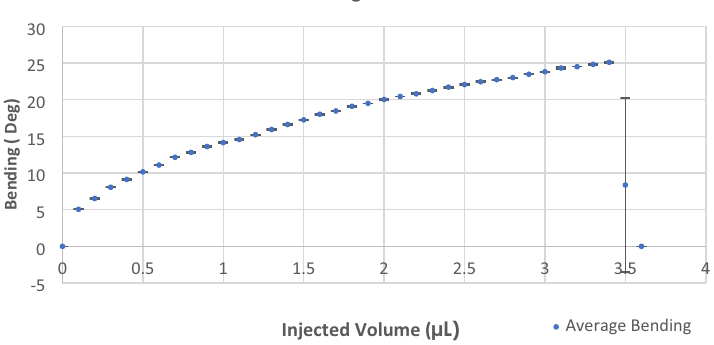
Figure 7. Non-linear behavior of the microgripper and rapture of the membrane. The bending of the finger was measured under an optical microscope. The angle (α) was measured as a function of the injected volume of water in the cavity. This measurement was performed for higher injected volumes and the rapture of the membrane was observed for volumes higher than 3.5 (µL) and angles higher than 25°.